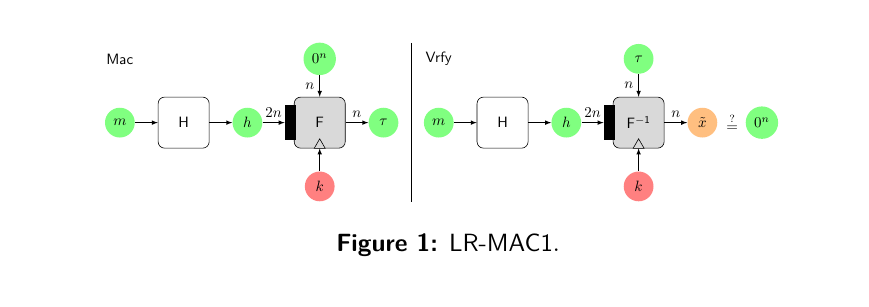
Figure 1: LR-MAC1